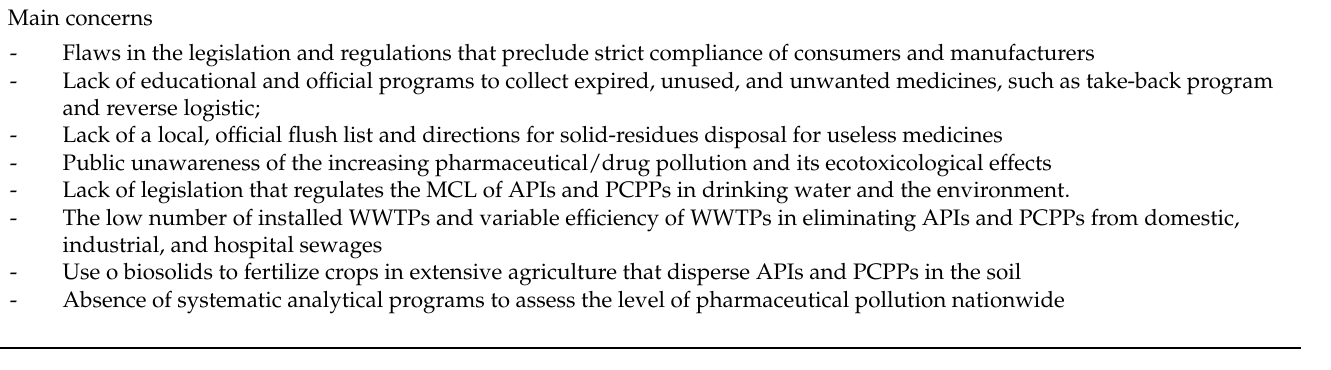
Table 4. Some concerns and recommendations about pharmaceutical/drug pollution in the Brazilian context. Main